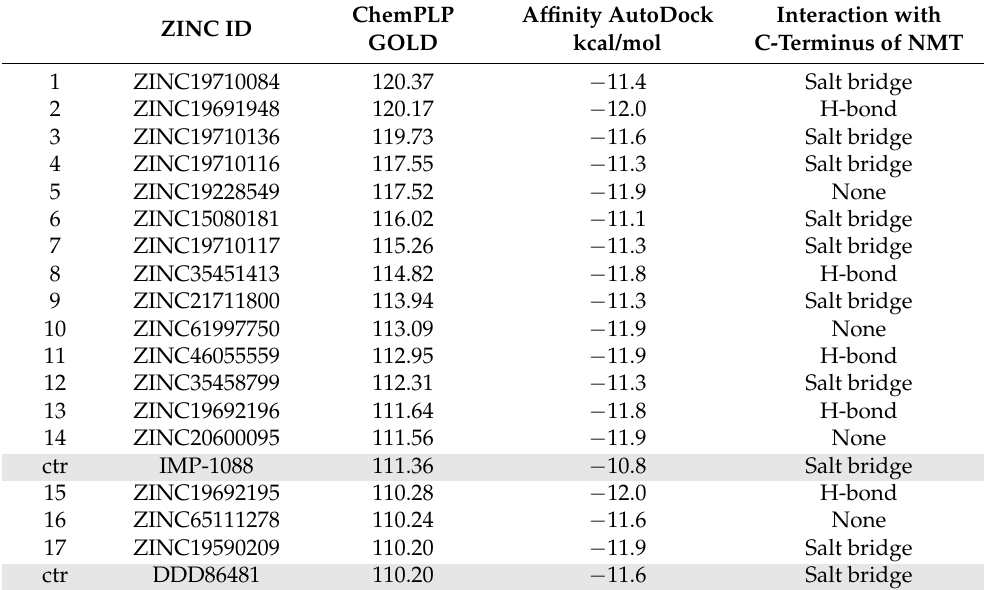
Table 1. The top scoring ligands of the virtual screening in GOLD. The ligands with ChemPLP score above the score of DDD86481 are shown. The AutoDock affinity of all ligands is equal to or higher than the one of DDD85646 ( − 11.1 kcal/mol). The control NMT inhibitors are shaded in grey. Complete list of ligands and their docking scores is provided in Table